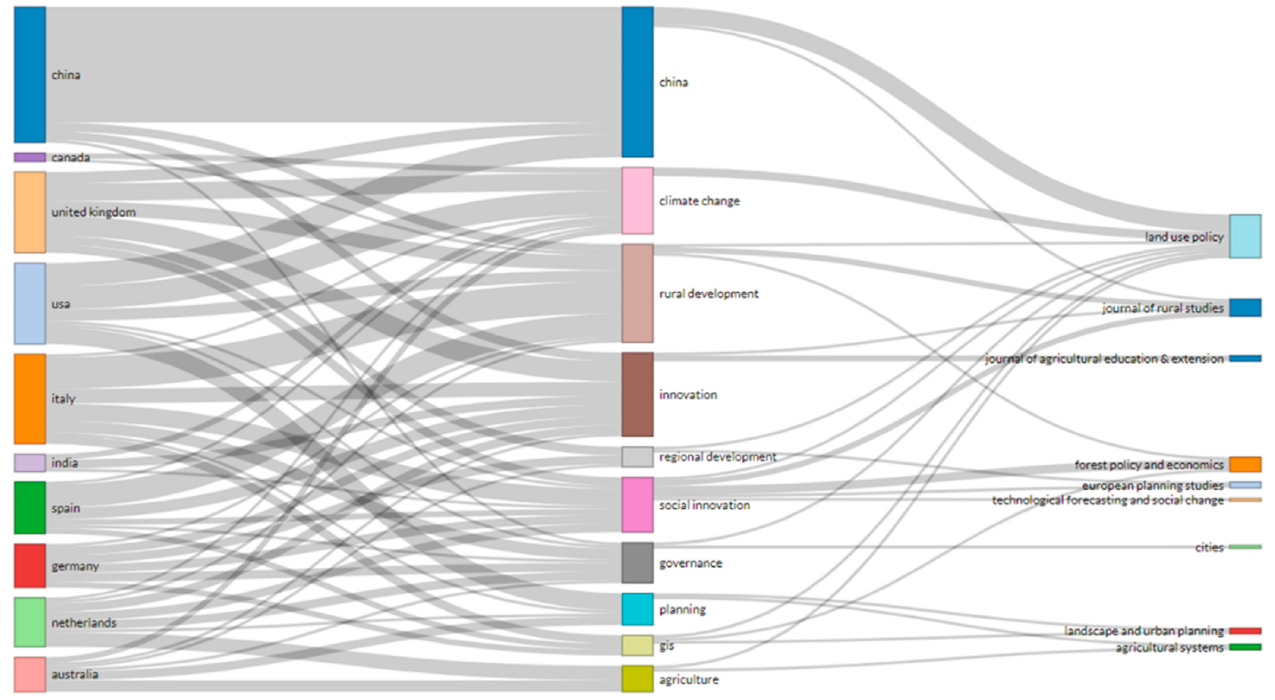
Figure 1. Three-fields plot of research topics for each country and the recency of the papers that they cited.